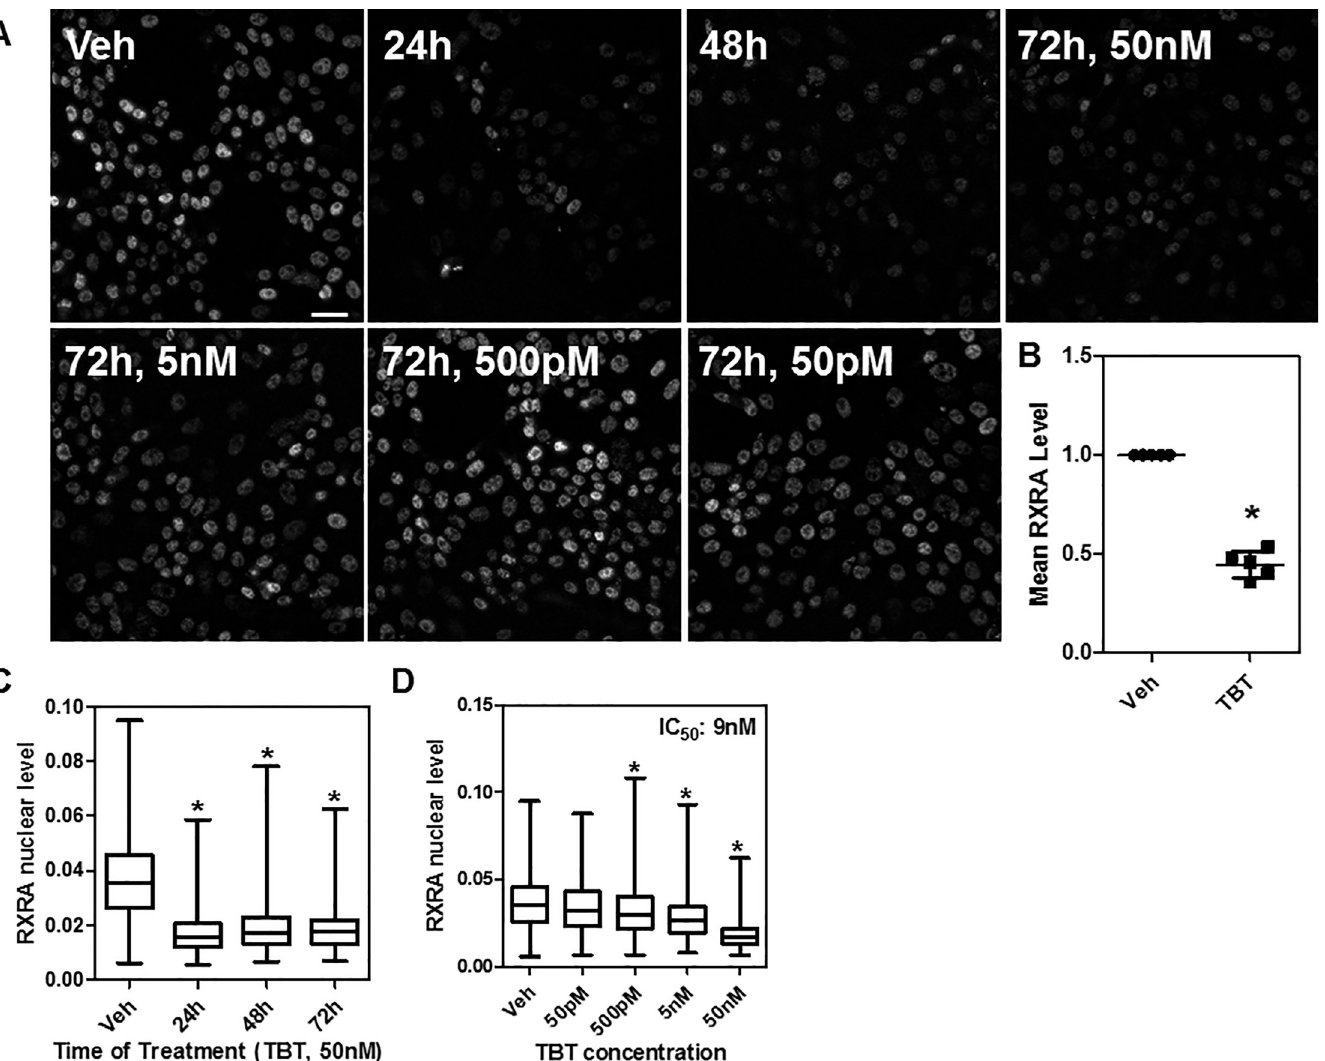
Fig 4. TBT down-regulates RXRA nuclear levels in a time- and dose-dependent manner in HepaRG cells. A) HepaRG cells were grown in the presence of TBT (50 nM) or vehicle for 1 to 3 days, then immunofluorescence was performed using specific RXRA antibody. Representative 20x images (max projection) are shown. Scale bar: 25 μ m. B) Fold change of RXRA down-regulation at 72h is reproducible across five independent experiments. C-D) box plots representing single cell data from panel A after high throughput microscopy and image analysis. � p < 0.05 by ANOVA (Kruskal-Wallis test with Dunn post test); in panel B a non-parametric t-test was used.